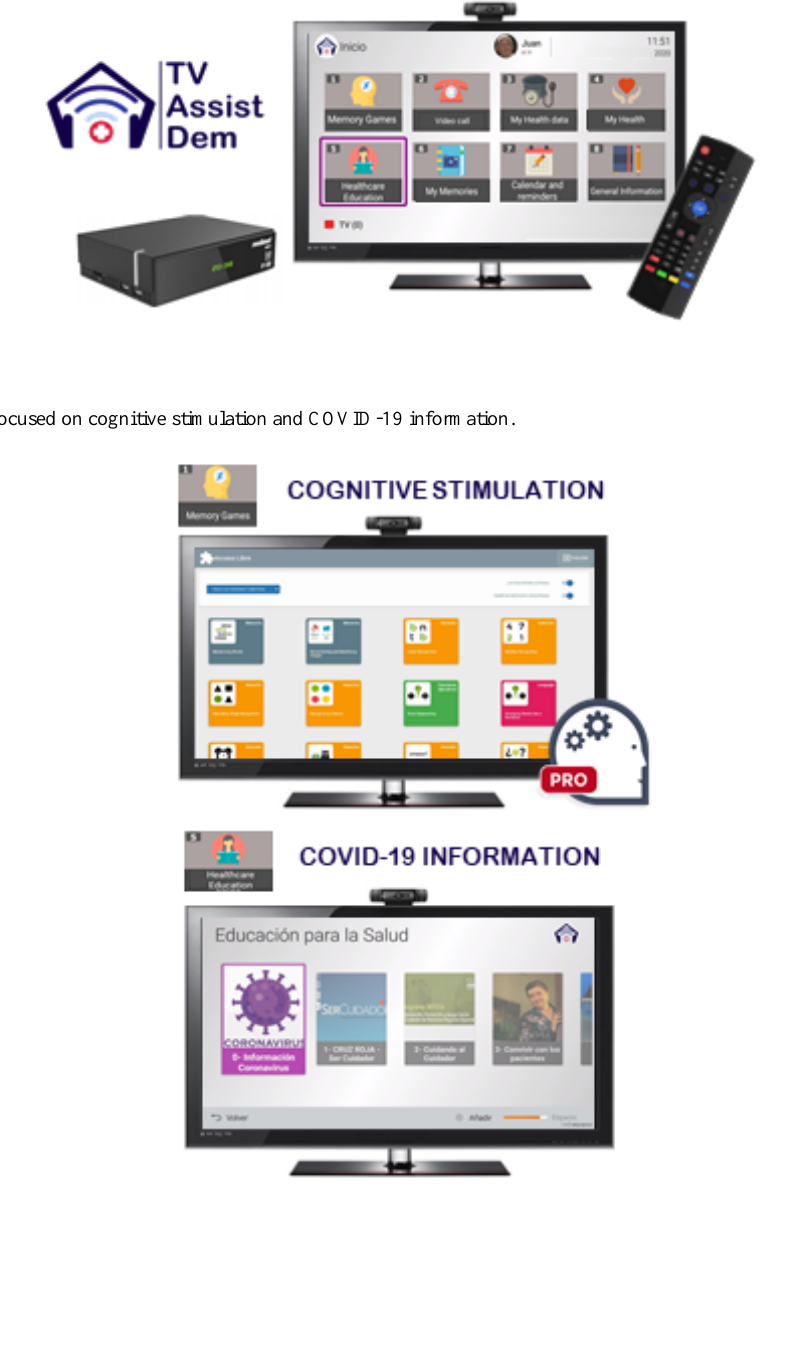
Figure 1. TV-AssistDem adapted to provide tailored support during COVID-19.